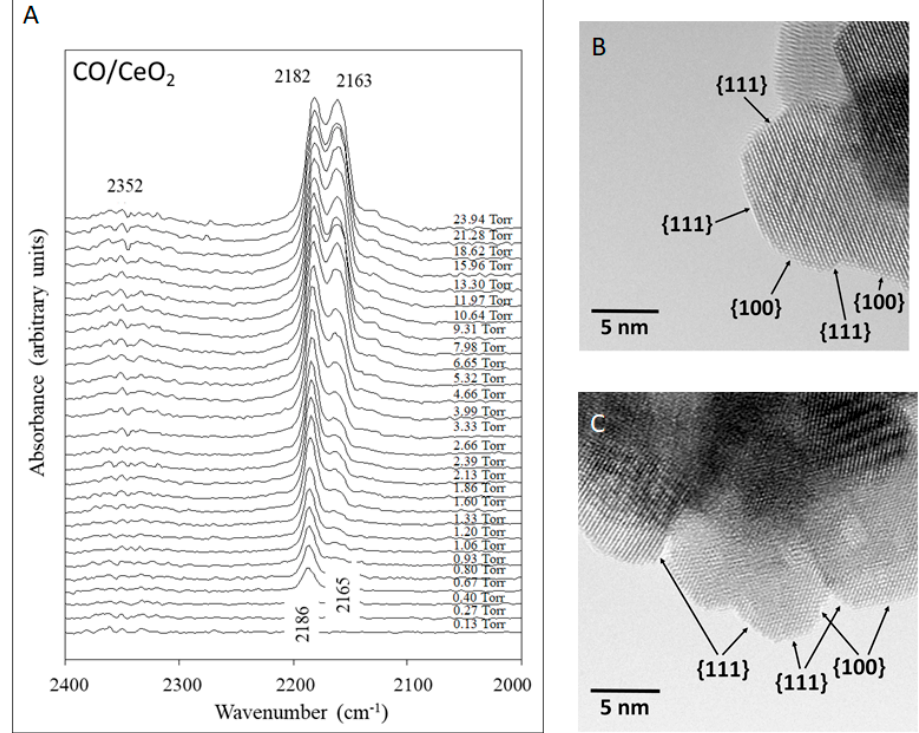
Figure 1. ( A ) Fourier Transform Infra Red (FT-IR) spectra of CO adsorbed on CeO 2 at 90 K. Indicated pressures are those of CO (upon exposure at the indicated pressure for 1 min each), spectra are collected at ~10 − 4 Torr. ( B , C ) High resolution transmission electron microscopy (HRTEM) of the CeO 2 particles on which the surface termination is